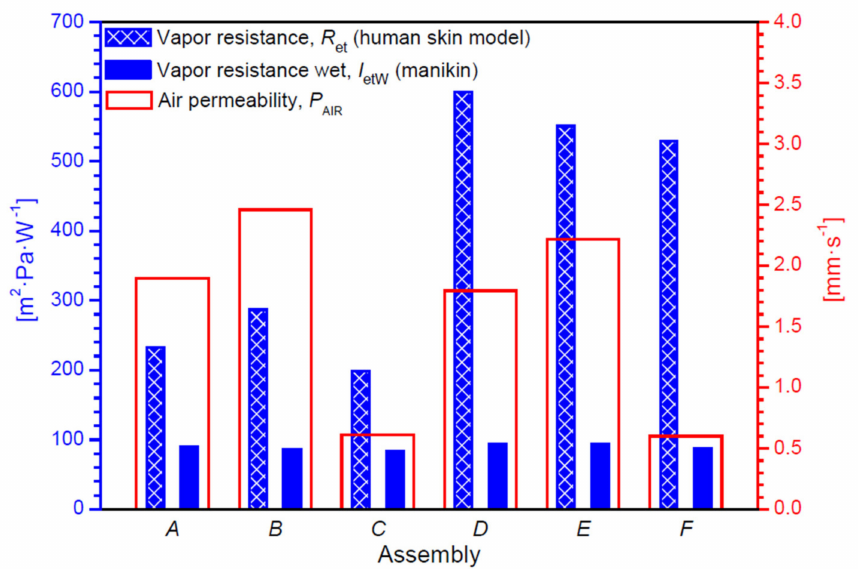
Figure 11. Measured biophysical properties of tested